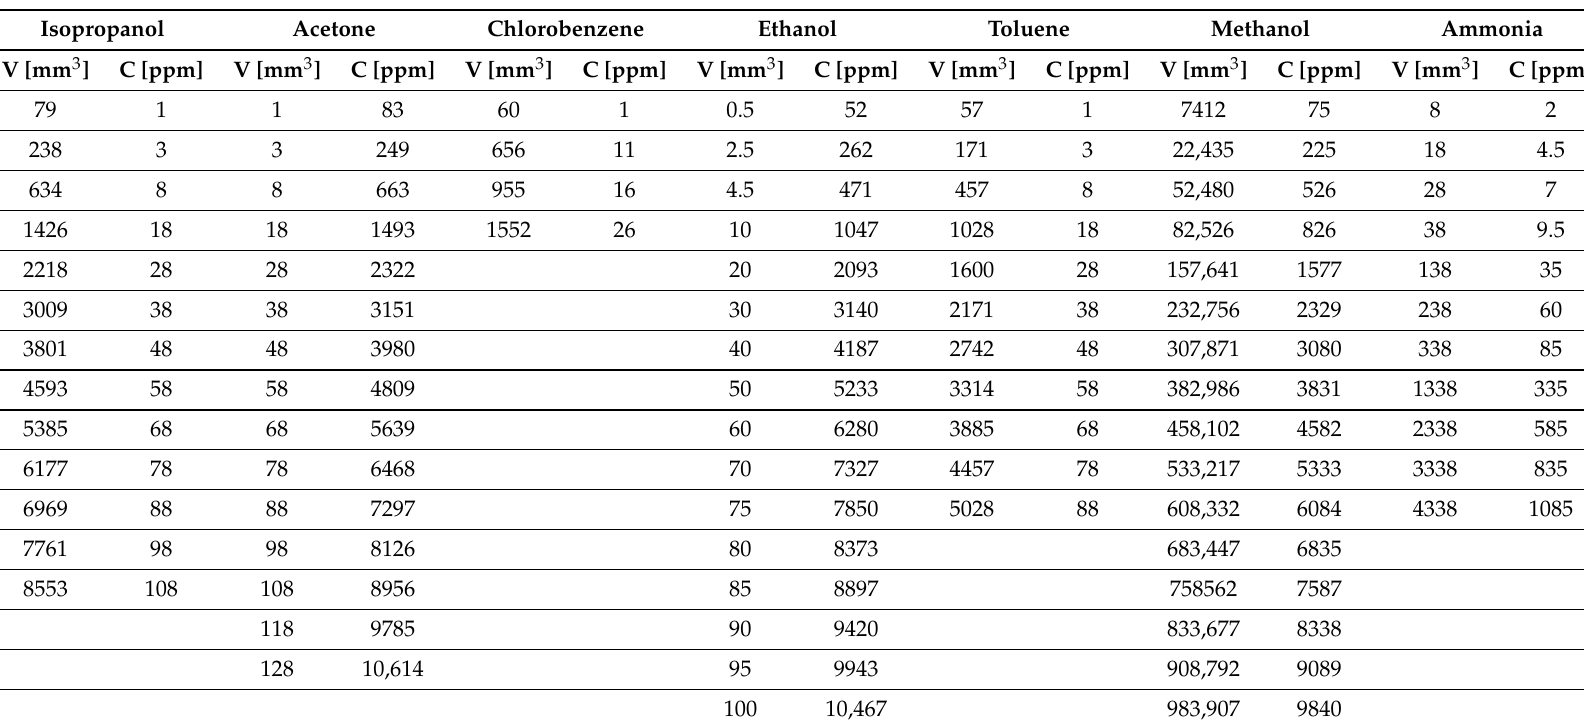
Table A1. Table of injected volumes (in mm 3 ) and the corresponding concentrations (in ppm) of liquid organic solvents and ammonia gas. See Section 2.4 for details.